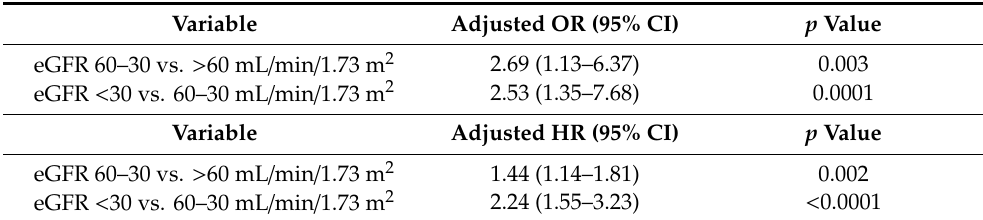
Table 4. Adjusted OR for in-hospital mortality and hazard ratio (HR) for long-term mortality between study groups.